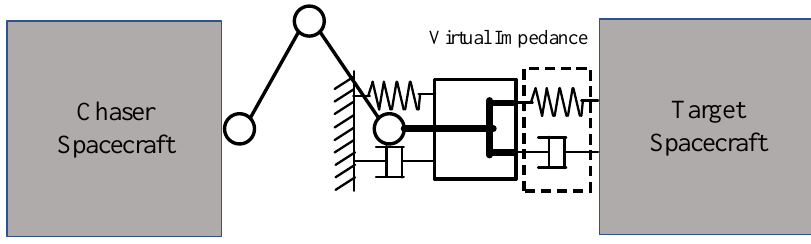
Figure 3. Impedance control model for the capture operation.